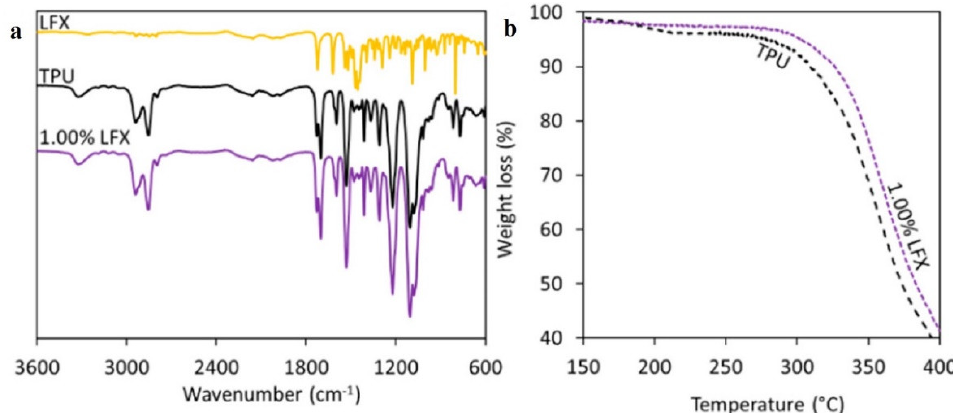
Figure 6. FTIR spectra of polyurethane (PU) and levofloxacin loaded filaments ( A ). TGA of PU and PU containing 1% LFX ( B ). Reprinted from [26] with permission from MDPI.